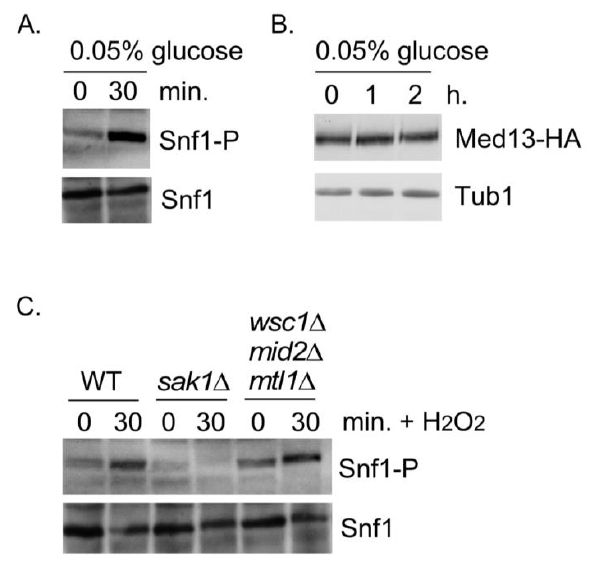
FIGURE 4: Snf1 activation does not mediate Med13 degradation. (A) Mid-log -type cells (RSY10) growing in 2% glucose (T=0) were switched to media containing 0.05% glucose. Snf1 phosphoryla- tion and Snf1 itself were detected as described in materials and methods for the timepoint indicate. (B) Wild-type cells harboring Med13-HA (pKC801) were switched to media containing 0.05% glucose. Med13-HA levels were detected by Western blot analysis for the timepoints indicated. Tub1 was used as a loading control. (C) As in (A) except that Snf1 phosphorylation was monitored after 0.4 mM H 2 O 2 treatment in the strains